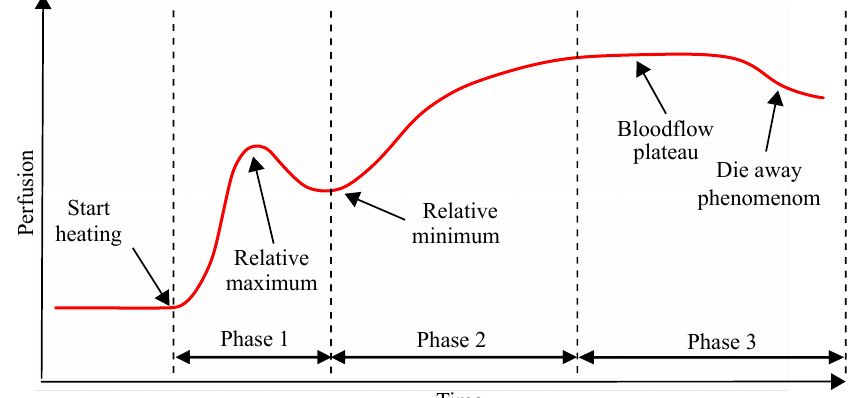
Figure 1. Skin perfusion as a function of time during warming of the considered body portion according to Kellogg et al.